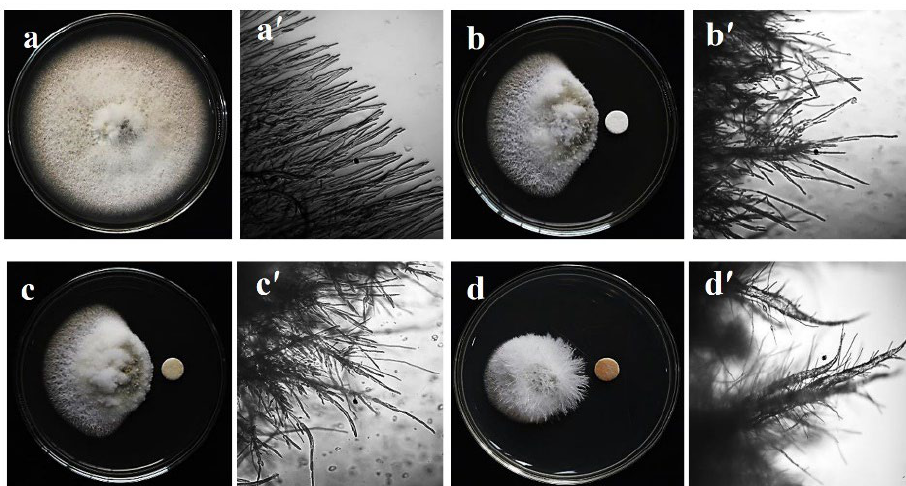
Figure 1. Mycelial growth suppression and morphological changes of hyphae of a wheat blast fungus, Magnaporthe oryzae Triticum (MoT) isolate BTJP 4 (5) approaching the paper disks containing two marine natural products, bonatin and feigrisolide C, and Nativo ® WG75 (20 µg/disk), a commercial fungicide known to growers as local standard in Bangladesh. Normal mycelial growth ( a ) of BTJP 4 (5) on PDA plate (10 days) and microscopic view of the growing typical tubular hyphal tips ( a′ ) in the untreated control. Mycelial growth inhibition ( b ) and abnormal hyphal tips ( b′ ) closer to the paper disk containing bonactin. Inhibited mycelia ( c ) and curly and irregular growth of hyphal tips ( c′ ) by feigrisolide C. Mycelial growth inhibition ( d ) and severely damaged hyphal tips ( d′ ) by the Nativo ® WG75. Bar = 50 µm. The micrographs shown in panels A and B were captured with a digital camera (CAMEDIA C-3040 zoom; Olympus Optical Co. Ltd., Tokyo, Japan), and those in panels C and D were taken from a light microscope (IX70-S1F2; Olympus) by using the same digital camera connected to it.